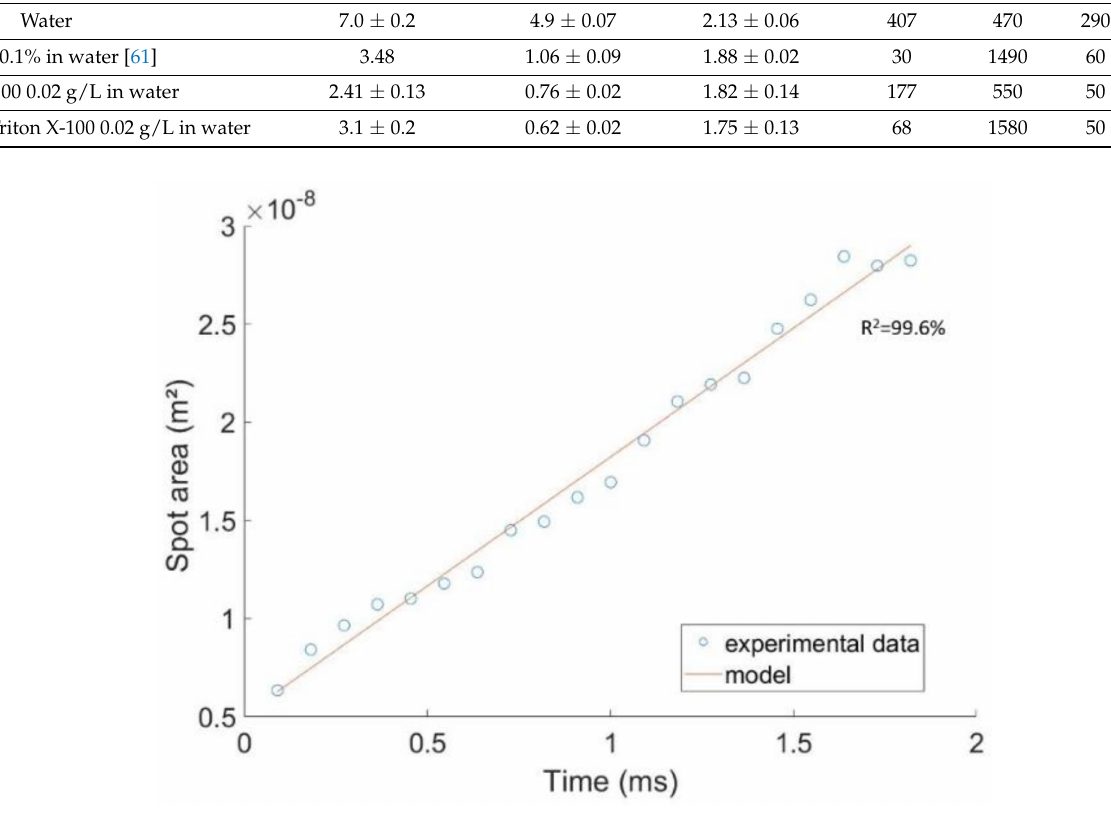
Figure 7. Area of the spot as a function of time after the bubble’s passage in a solution containing PAAm and Triton